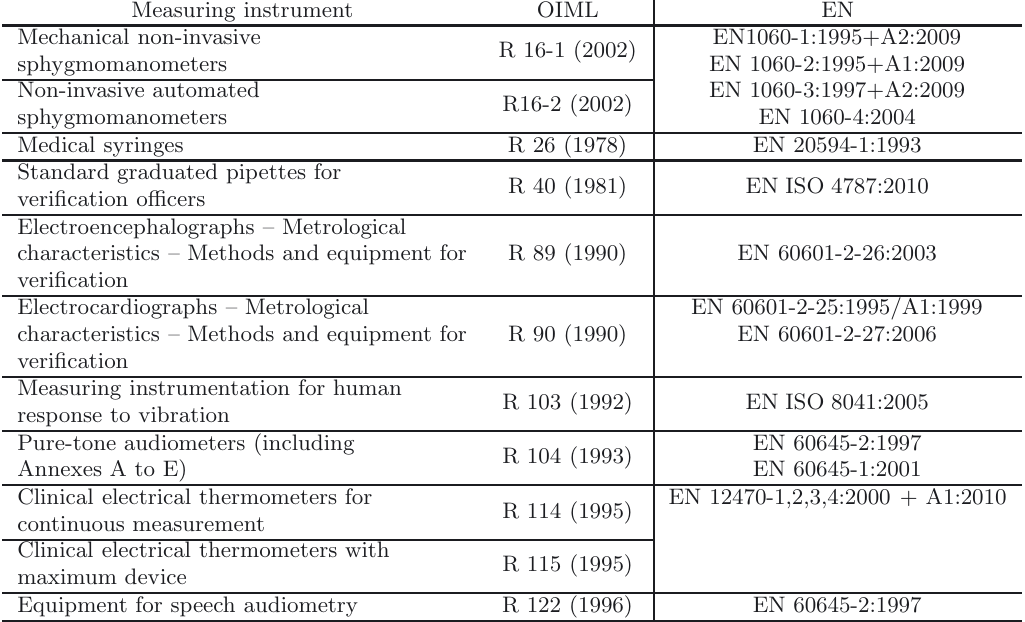
Table 2. Recomendation OIML and European Standards for some categories of medical